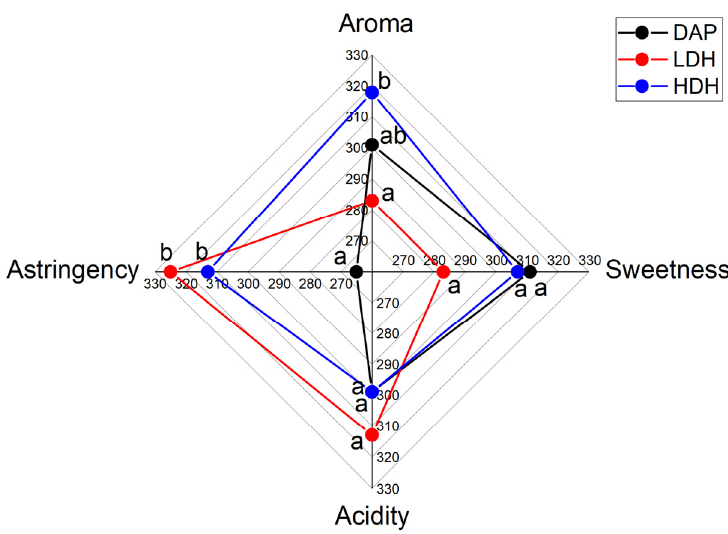
Figure 7. Parameterized results of the sensory attributes evaluation of Cabernet Sauvignon wines produced by supplemented fermentations with different nitrogen sources. Different letters indicate significant differences ( p < 0.05).